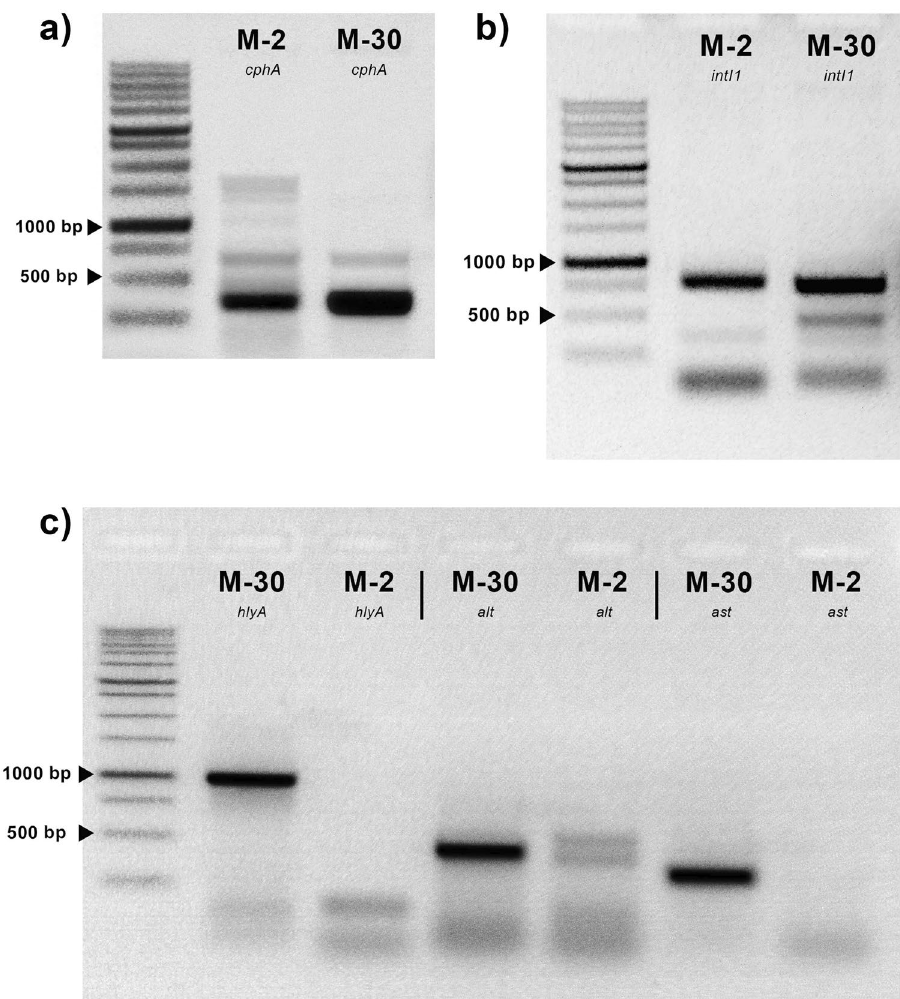
Figure 2. Agarose gel electrophoresis of target amplicons: ( a ) cphA gene (346 bp). ( b ) putative intI1 gene (920 bp). ( c ) major virulence genes— hlyA (1079 bp), alt (442 bp), ast (331